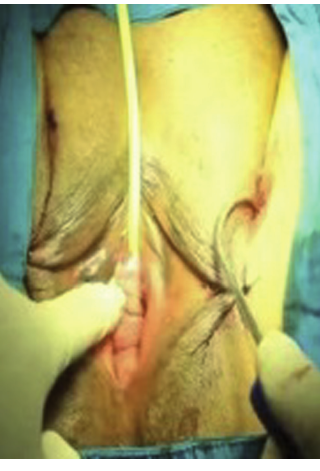
Figure 1 - The needle is pushed until it reaches 1.5cm below the urethral meatus (left).